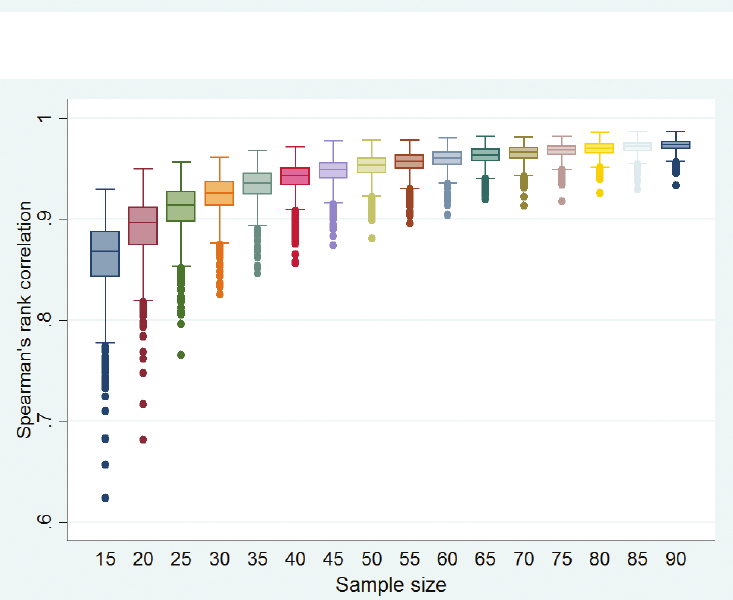
Figure 1. Level of overlap among the top 20 ranked research ideas (Y–axis) by the size of the sample of randomly selected experts (X–axis) from a total pool of 91 experts using a bootstrap method (simulation 1000 times with replace- ment of already selected experts, using bsam- pling function). The size of randomly generated samples ranged from 15 to 90 and it was based on the CHNRI exercise on newborn health research priorities [11].